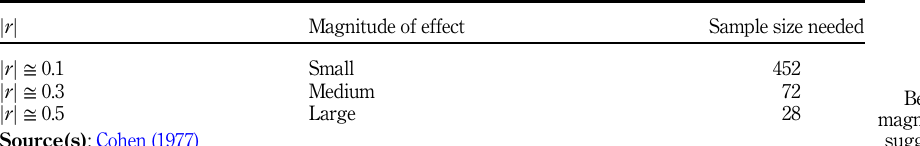
Table 8. Benchmarks for